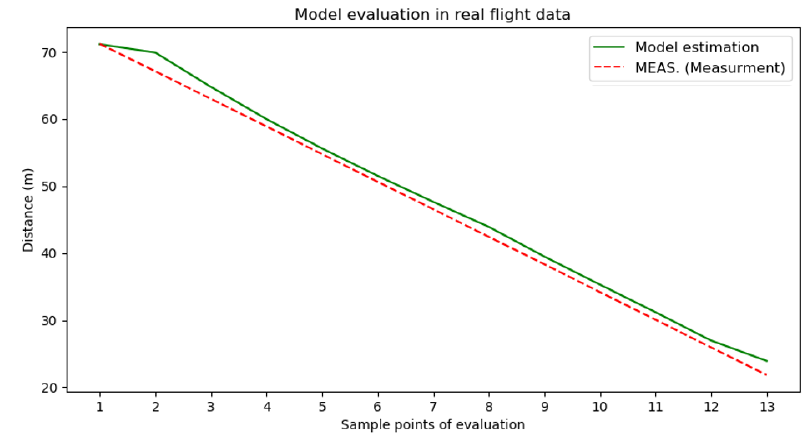
Figure 30. Measurements of GPS data for model evaluation in Experiment 4.